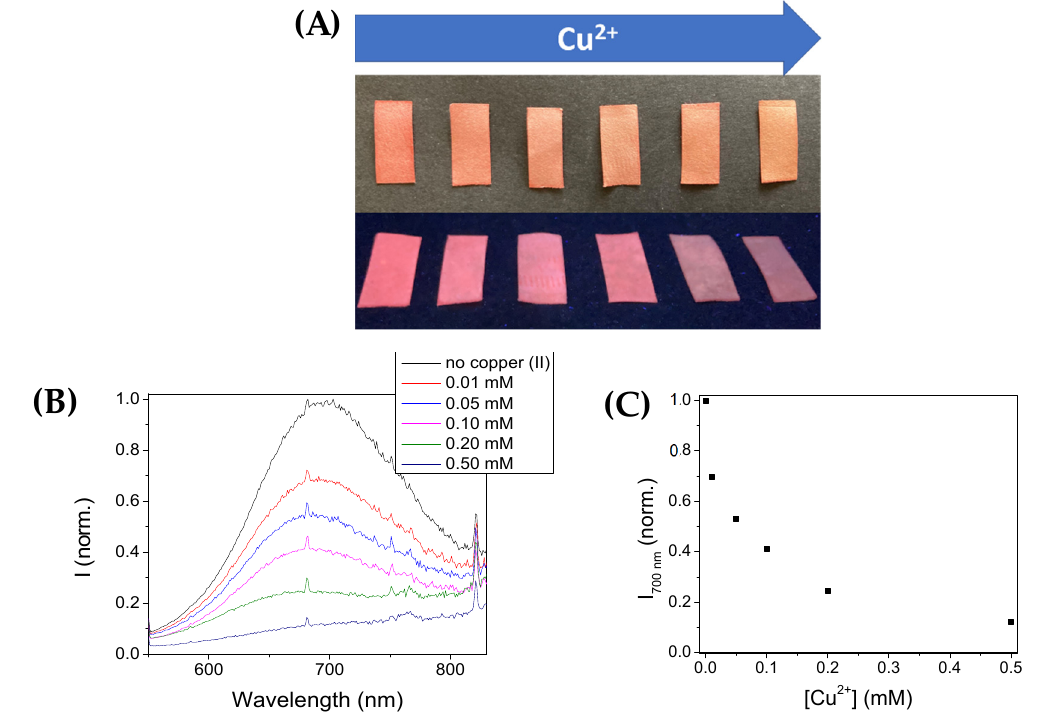
Figure 8. ( A ) Pictures of paper test-strips with embedded chemosensor 4 upon exposure to increasing copper concentrations (above: under ambient light; below: under 365 nm UV light). ( B ) Emission spectra from the paper test-strips, and ( C ) corresponding fluorescence intensity at 700 nm ( λ EXC = 500 nm).